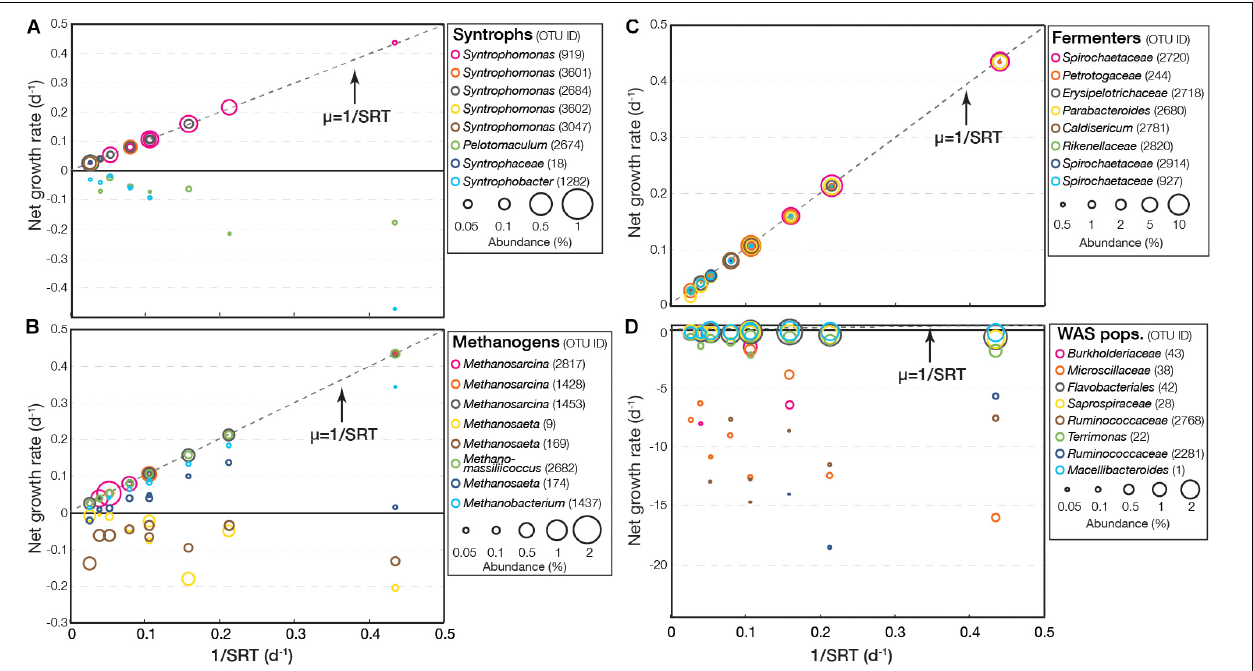
FIGURE 3 | Net growth rate of representative OTUs (top eight abundant) related to syntrophs, methanogens, fermenters, and WAS-associated populations in (A–D) experiment II.